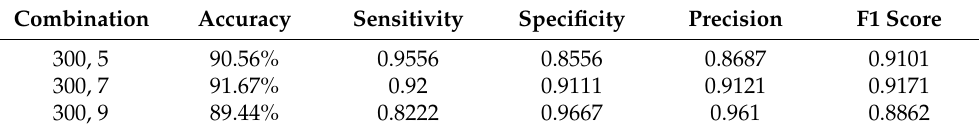
Table 2. Prediction pipeline performance for IVCF detection metrics from Figure